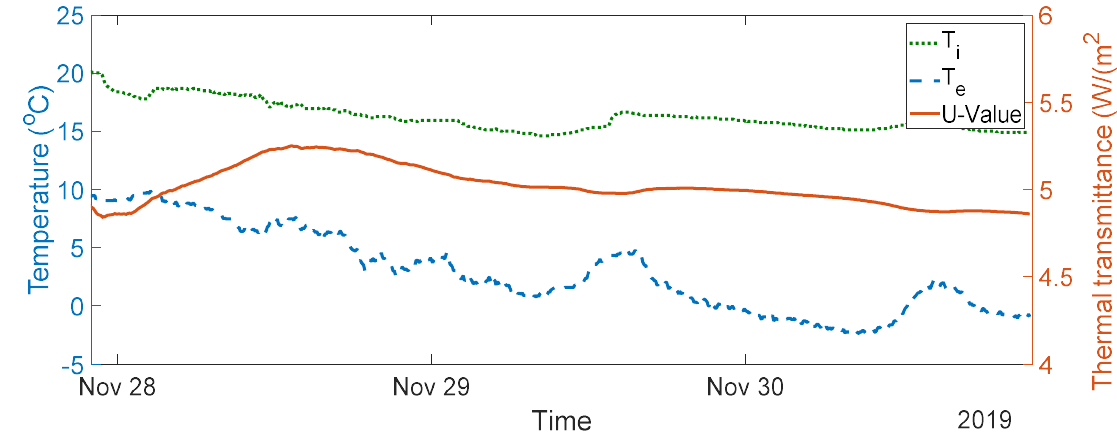
Figure 6. Thermal transmittance measurement data from Day 1 to Day 3. (W/(m 2 K)).